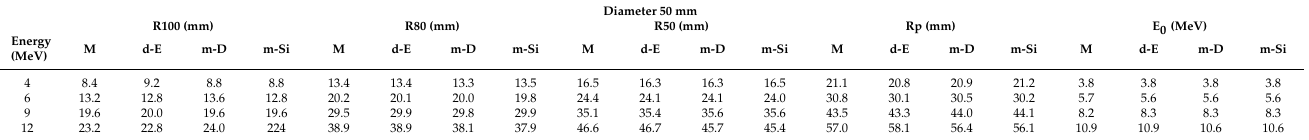
Table 2. Most relevant dosimetric parameters, extracted from PDD curves for the 50 mm diameter field, measured by ionization chamber Markus (M), diode E (d-E), microDiamond (m-D), and microSilicon (m-Si).